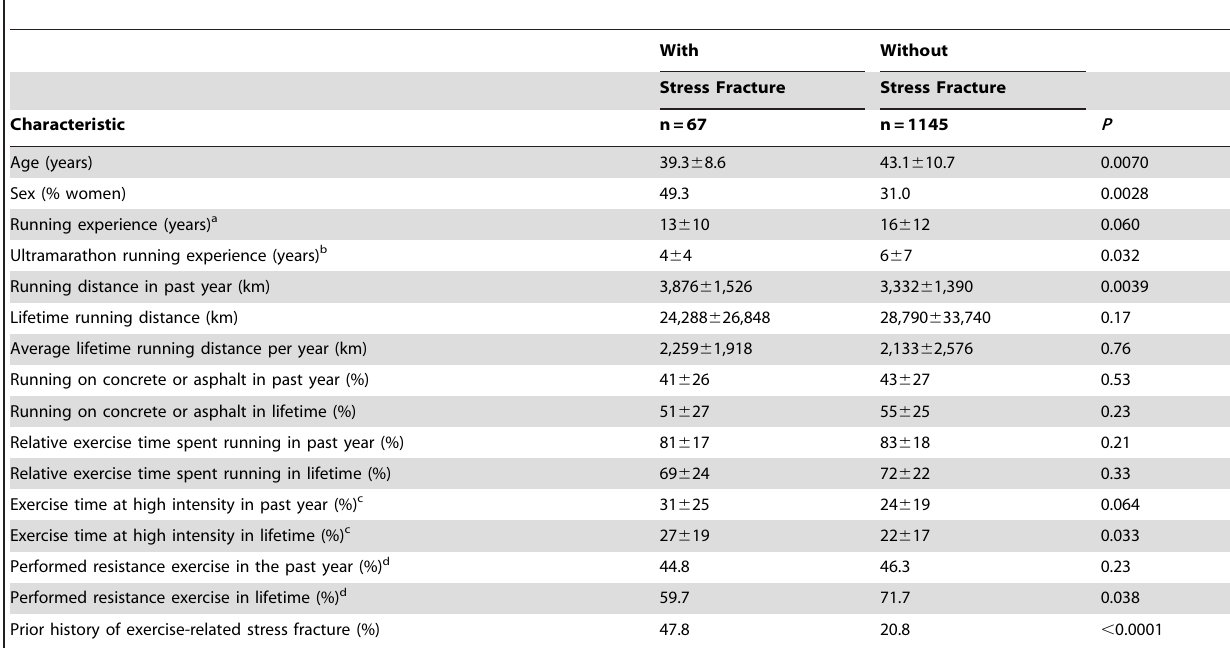
Table 7. Comparison of select characteristics of those reporting an exercise-related stress fracture in the prior 12 months with those who had not suffered as stress fracture.